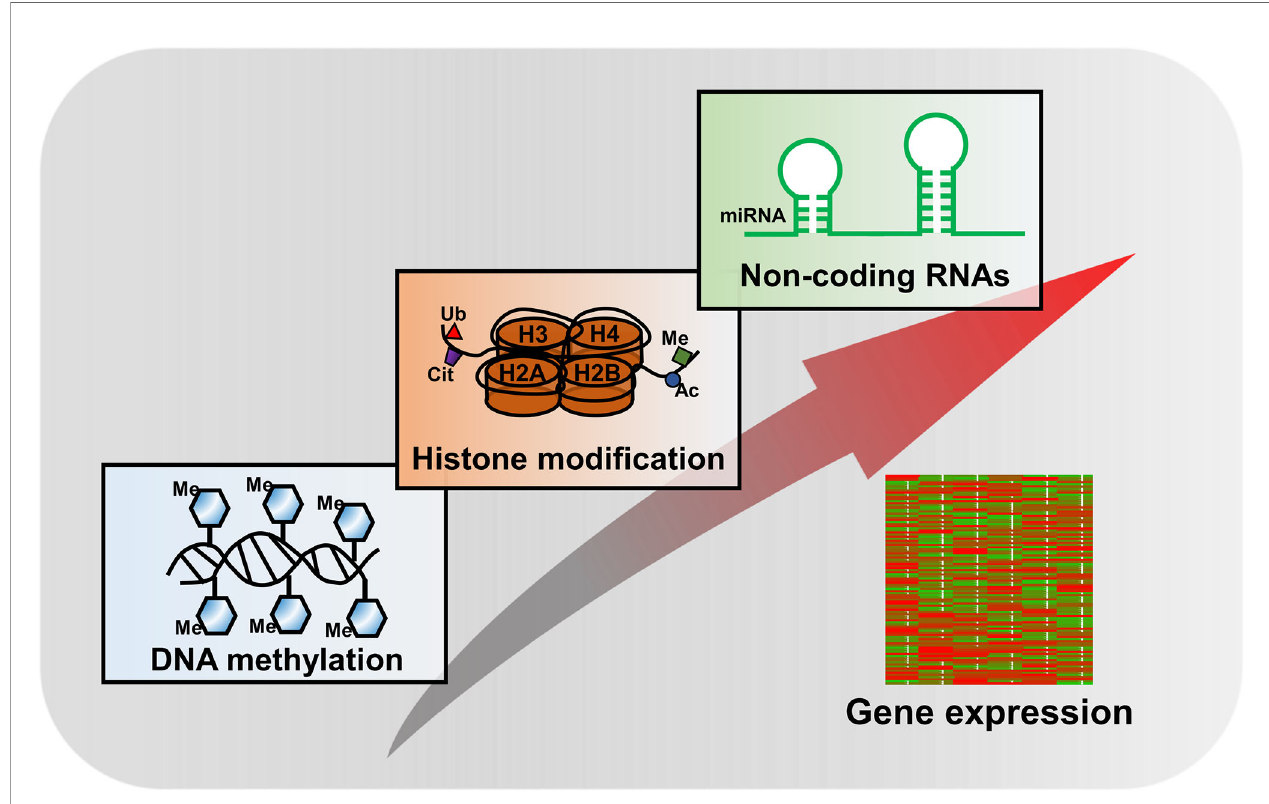
FIGURE 2 | Major epigenetic mechanisms in regulation of gene